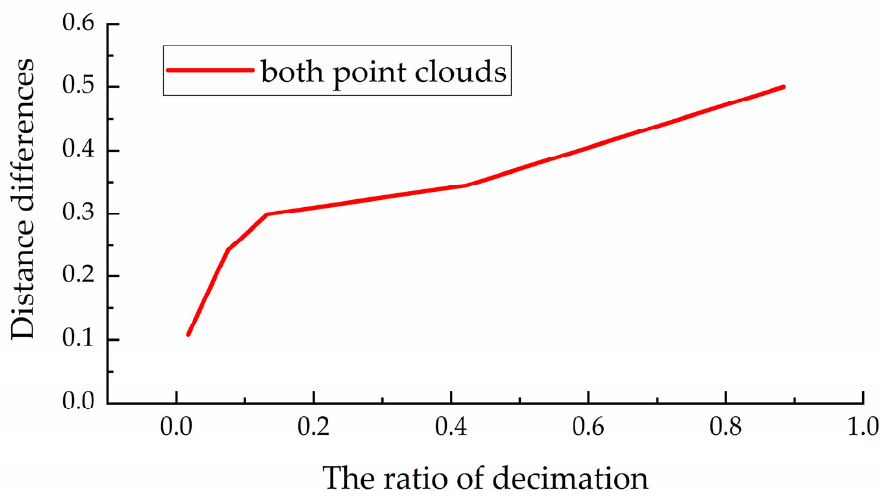
Figure 10. Robustness to varying point density.